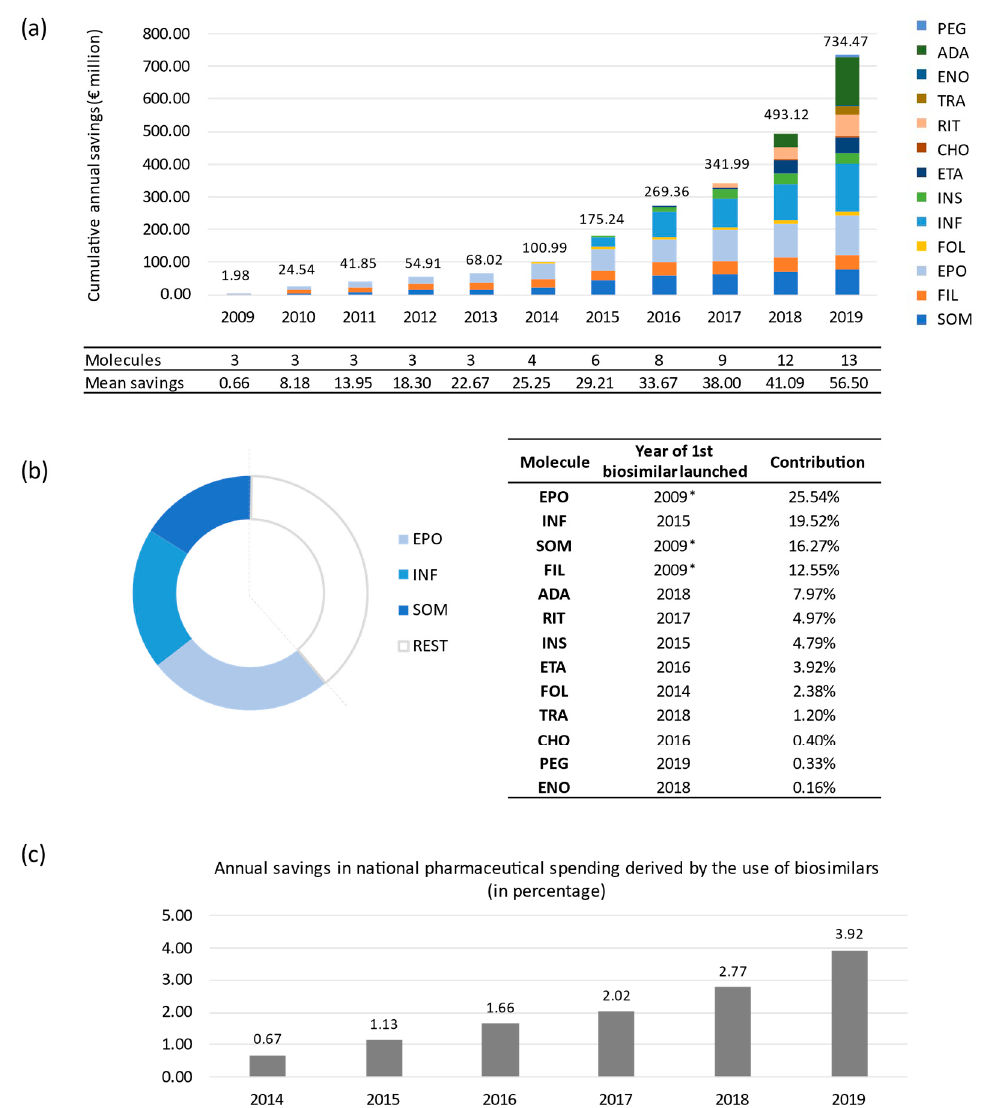
Figure 2 . Distribution of aggregate savings. ( a ) Aggregate savings over time. All molecules exposed to biosimilar competition each year were included in the analysis.; ( b ) Specific contribution of each of the molecules to the total amount of savings. SOM: somatropin; FIL: filgrastim; EPO: epoetin; FOL: follitropin alfa; INF: infliximab; INS: insuline glargine; ETA: etanercept; CHO: chondroitin sulfate; RIT: rituximab; TRA: trastuzumab; ENO: sodium enoxaparin; ADA: adalimumab; PEG: pegfilgrastim. * Biosimilars marketed before 2009: somatropin, 2006; filgrastim and epoetin, 2008 (2009 is the